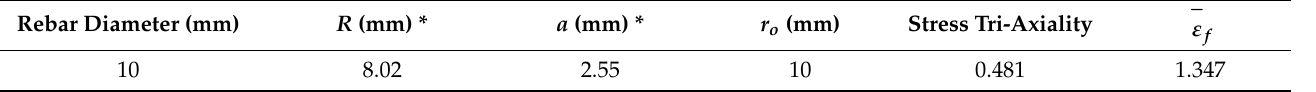
Table 6. Stress tri-axiality and ε f of steel rebars.